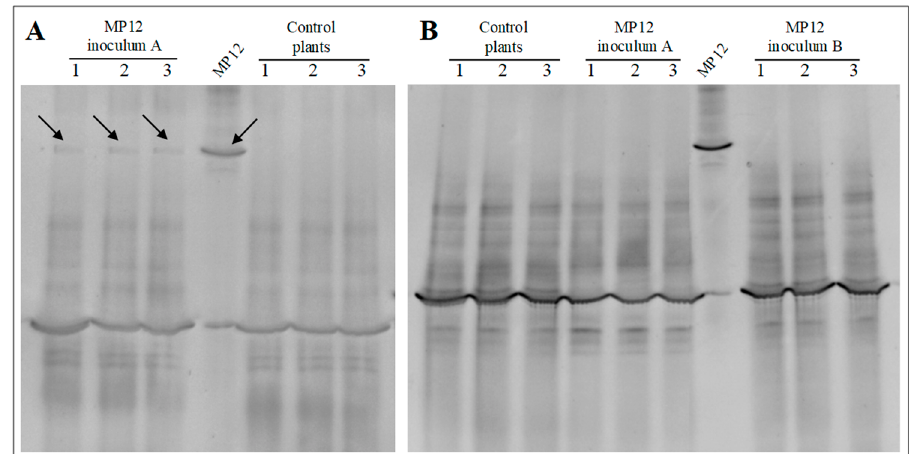
Figure 4. ( A ) PCR-DGGE analysis on leaves of both grafted vine plants inoculated with MP12 strain by endophytic inoculum A and uninoculated plants after the forcing period lasted one month. ( B ) DGGE analysis on leaves of plants inoculated with MP12 strain by endophytic inoculum A and B after one month of permanence in the vine nursery field. Fragment amplified from P. protegens MP12 was used as